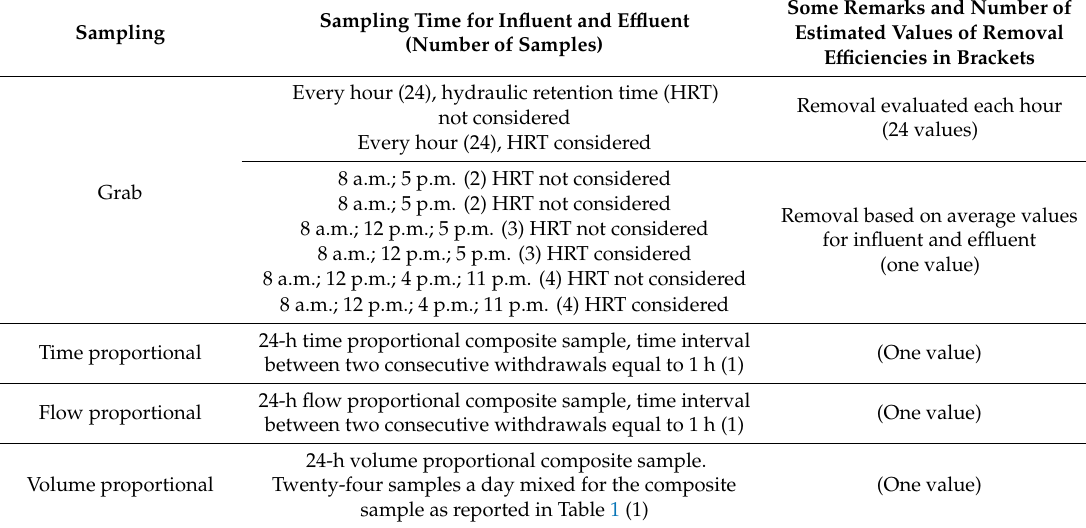
Table 2. Description of the sampling modes adopted and compared in this study for the removal e ffi ciency evaluation of